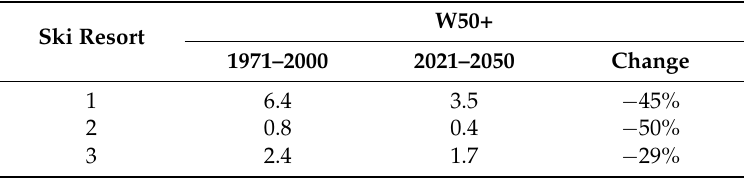
Table 4. Projected Changes for Annual Lift Closure Days at the Major Ski Resorts in Northeast Turkey according to the RCP4.5